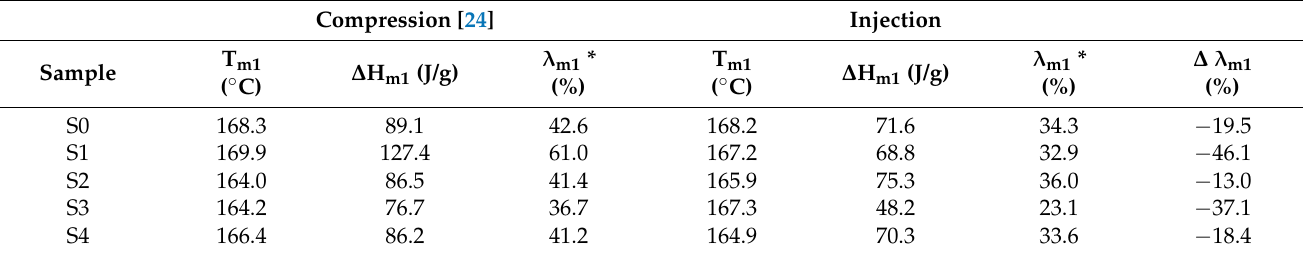
Table 3. Thermal parameters from DSC without erasing the previous thermal history fingerprint (first heating